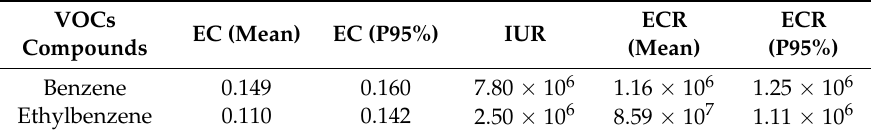
Table 6. Carcinogenic risk due to the inhalation of benzene and